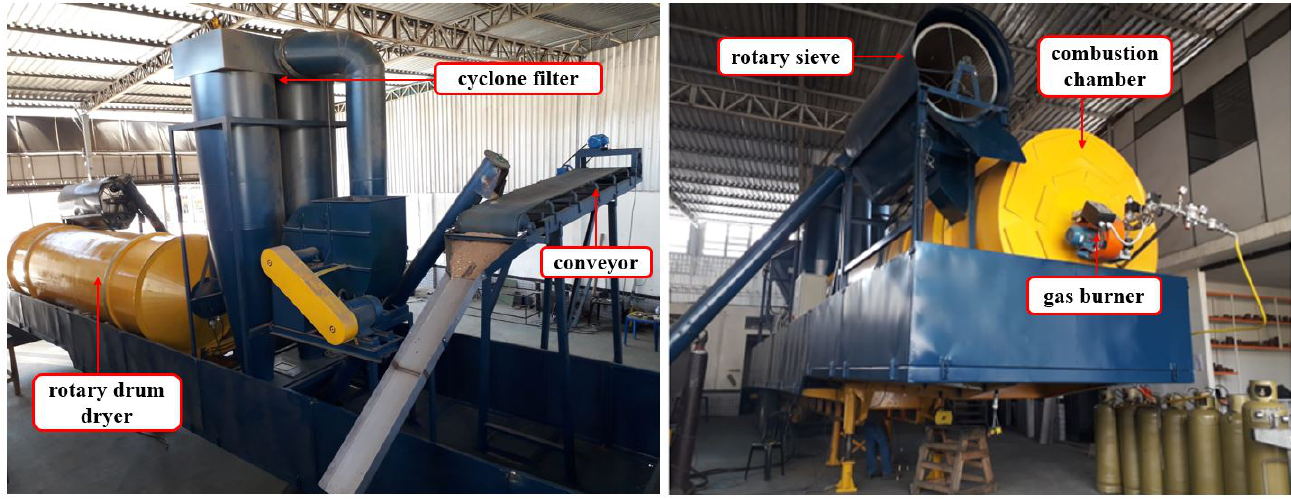
Figure 5. Drying